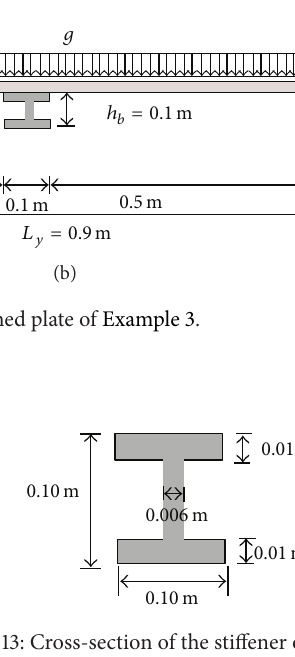
= 𝜌 = 2.5 tn / m 3 , ] 𝑝 𝑏